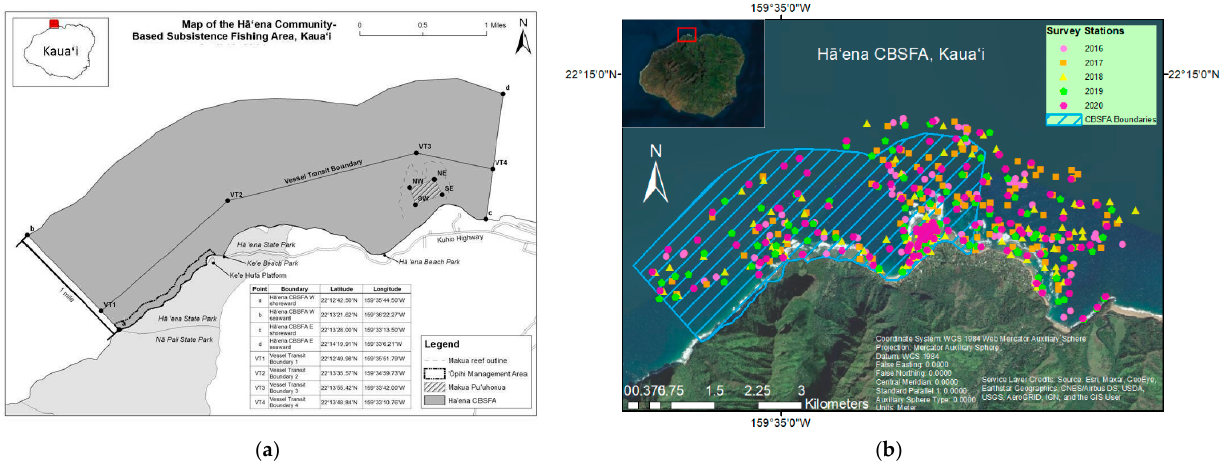
Figure 1. H ā ʻ ena site maps of ( a ) community-based subsistence fishing area (CBSFA) boundaries, the restricted Makua pu ʻ uhonua, the vessel transit boundary, and the ʻ opihi (limpet, Cellana spp.) management area with coordinates [28] and ( b ) survey stations from all five years within and outside the CBSFA boundaries.